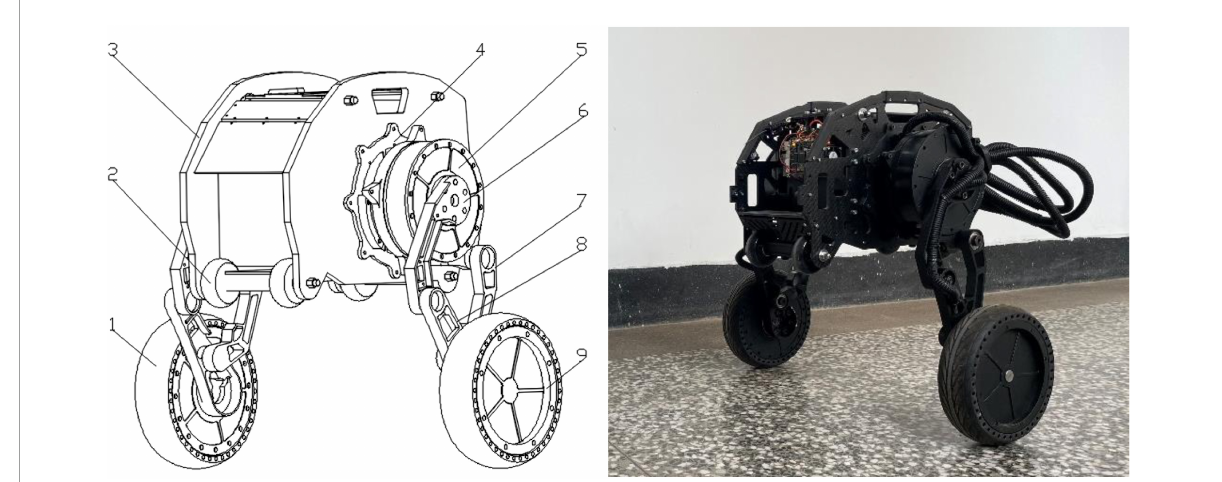
FIGURE1 Schematic diagram of the robot structure. 1. Right wheel (driving wheel); 2. Universal wheel; 3. Body; 4. Waist motor; 5. Hip motor; 6. Connecting rod 1; 7. Connecting rod 2; 8. Connecting rod 3; 9. Left wheel (driving